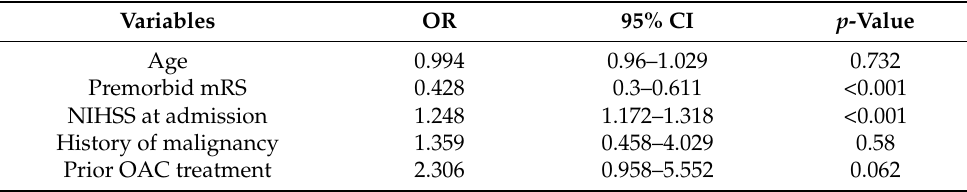
Table A3. Logistic regression model for performing acute interhospital